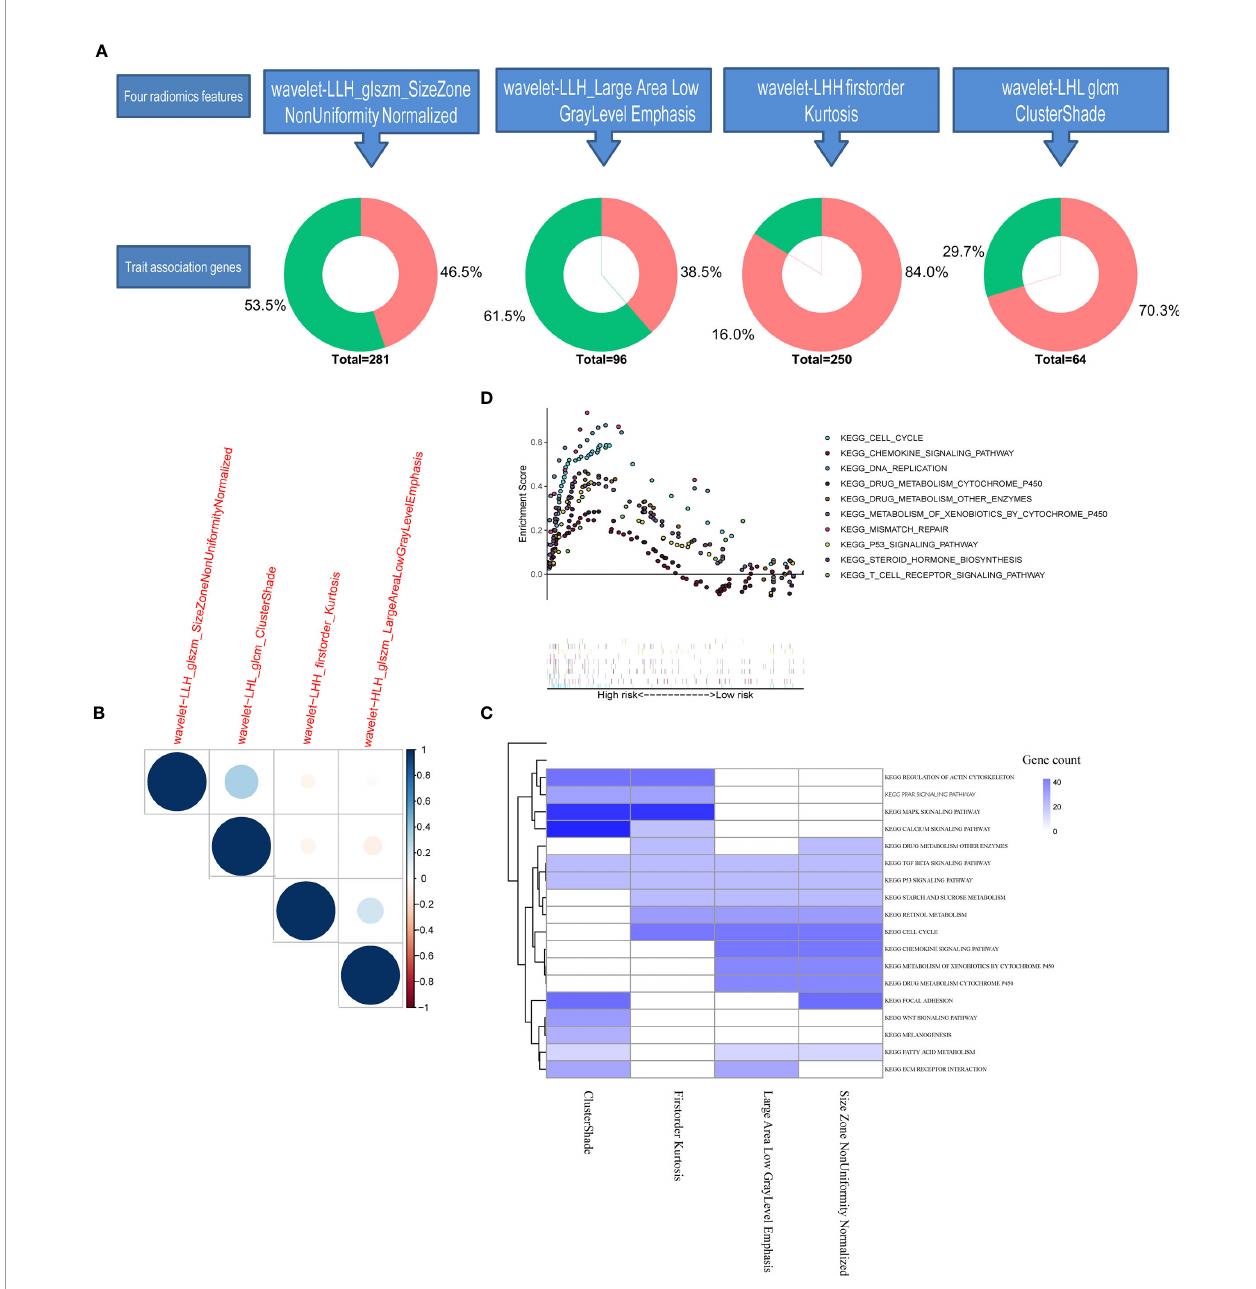
FIGURE 6 | Tarit-association genes and functional enrichment analysis. (A) Each differently expressed gene in four radiomics features in the genomic study. (B) Heatmap of the similarity between each train-associated gene calculated by the Spearman index. (C) Heatmap of GESA enrichment analysis. (D) GSEA enrichment analysis of the radiomics score